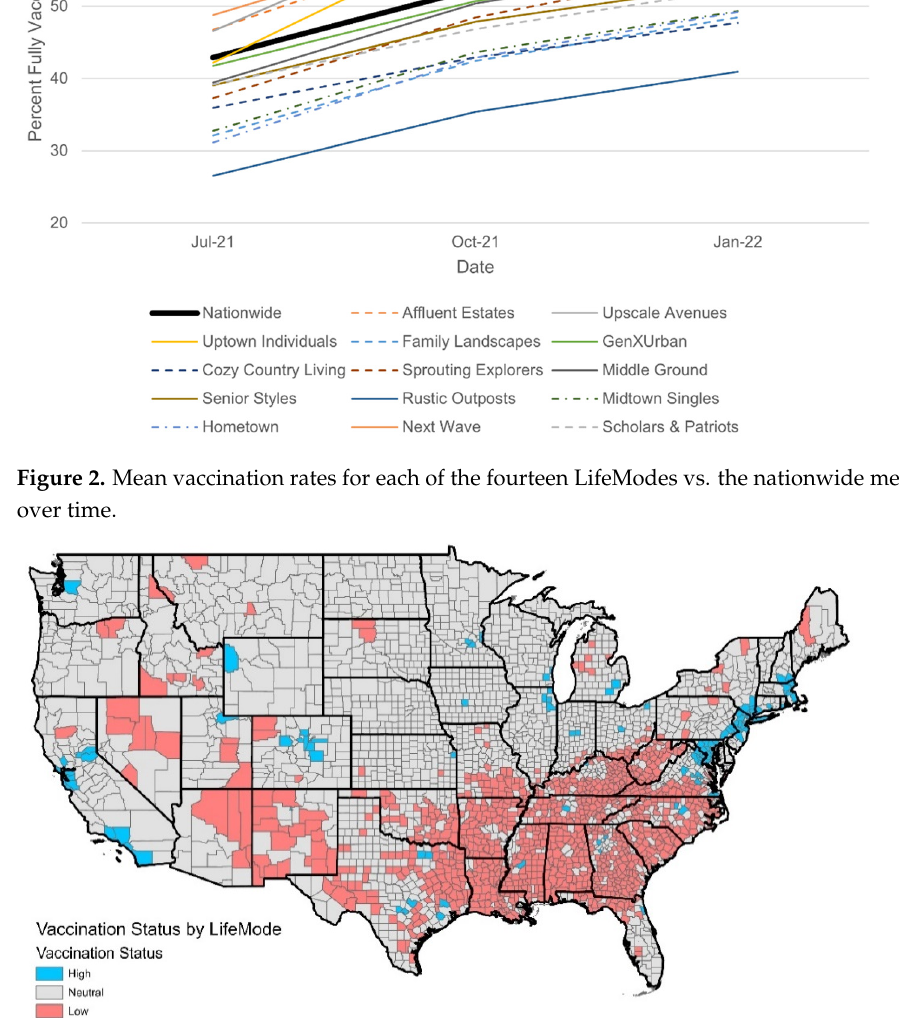
Table 2. Model coefficients and significance levels for the predictor variables (principal components 1 through 7).